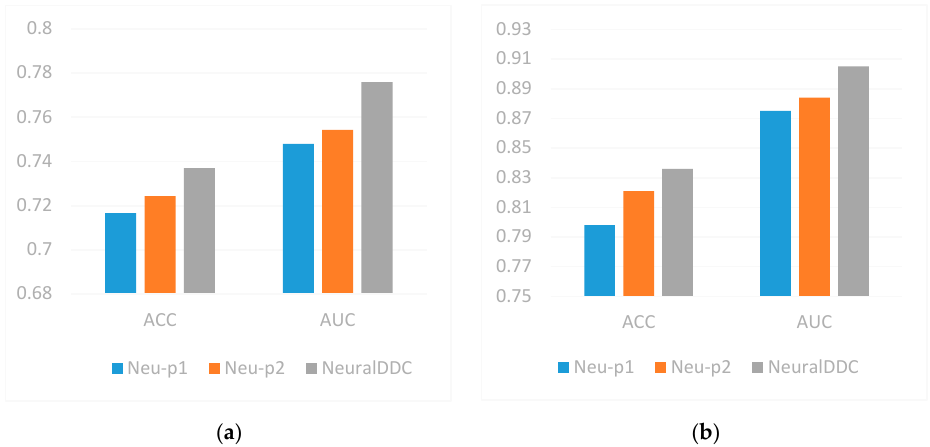
Figure 2. Model performance comparison of Neu-p1, Neu-p2 and NeuralNCD on datasets ( a ) ASSIST2009, ( b )